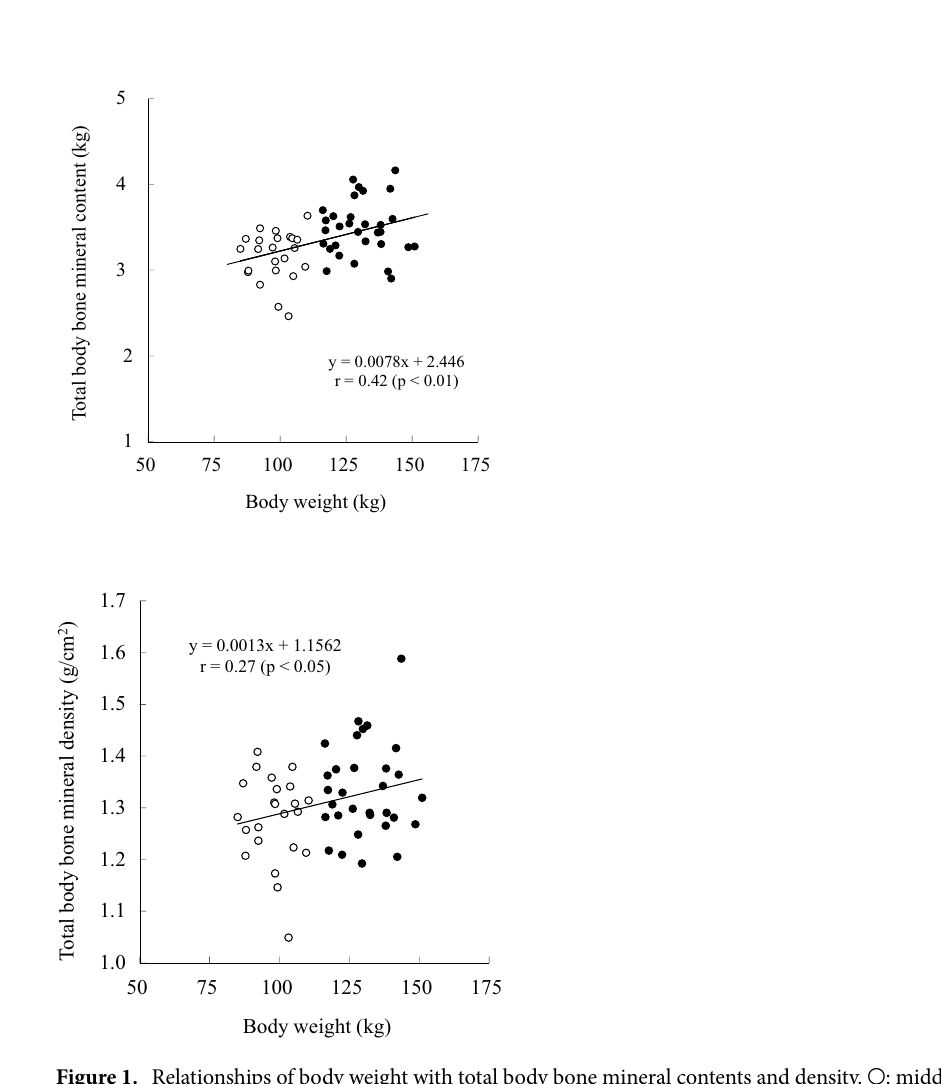
Table 2. Total and regional bone mineral content and density. Middle weight vs. Heavy weight: * p < 0.05, ** p < 0.01.